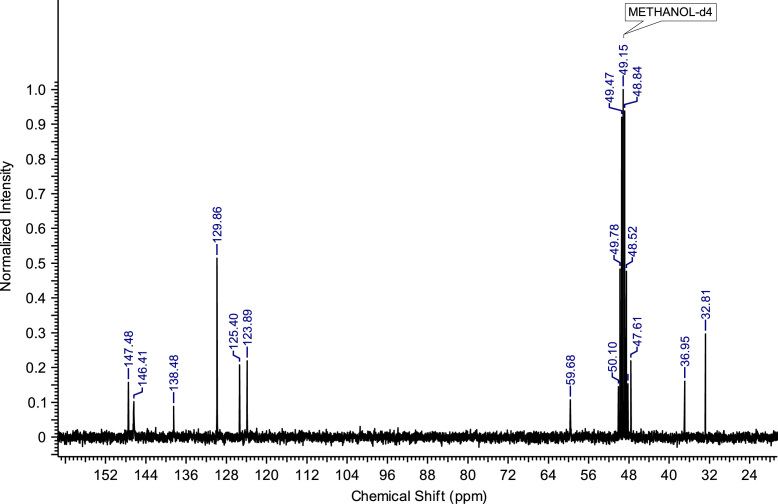
13C NMR spectra of C3(Pyr)(MIm)Br2.